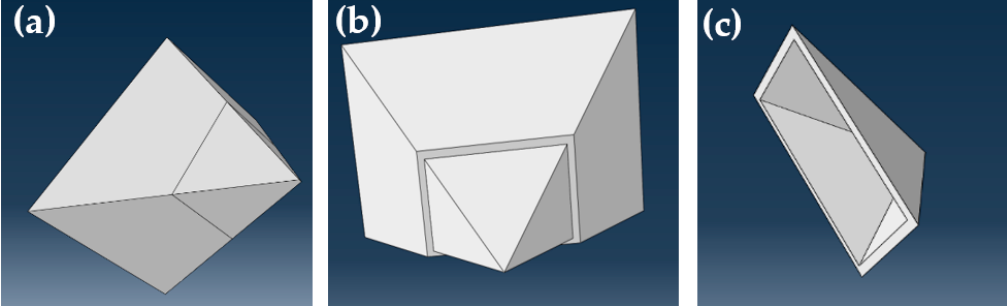
Figure 10. ( a ) Model of tooth cutter element for shield machine; ( b ) body part; ( c ) shell part.